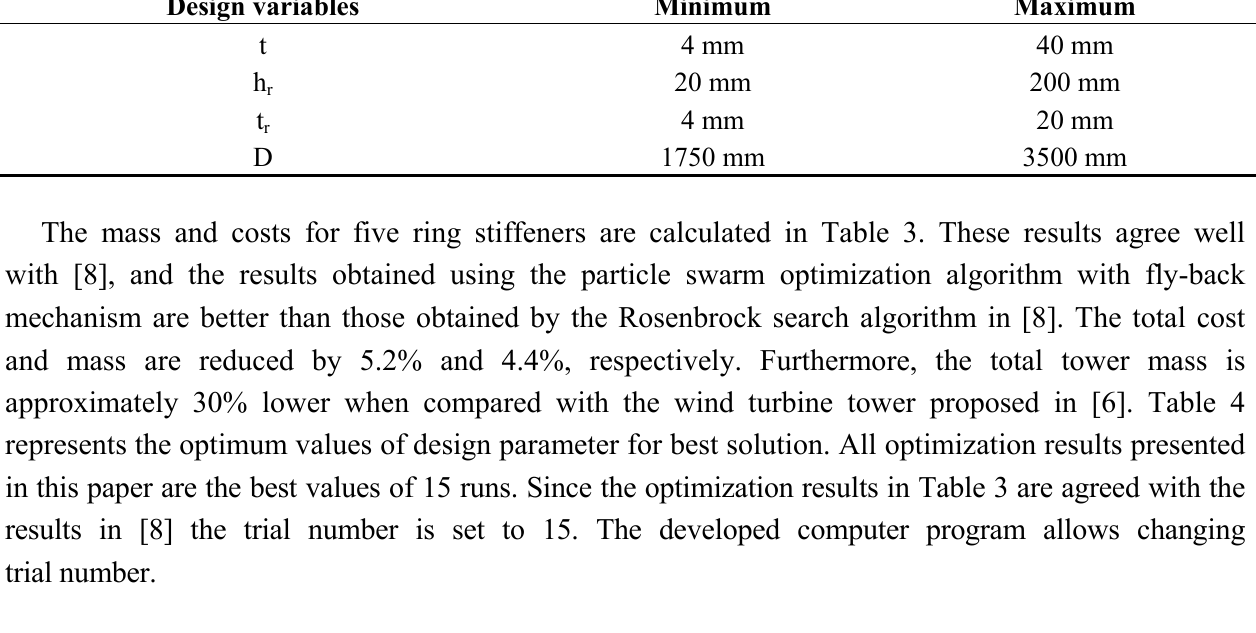
Table 3. Comparison of the optimization